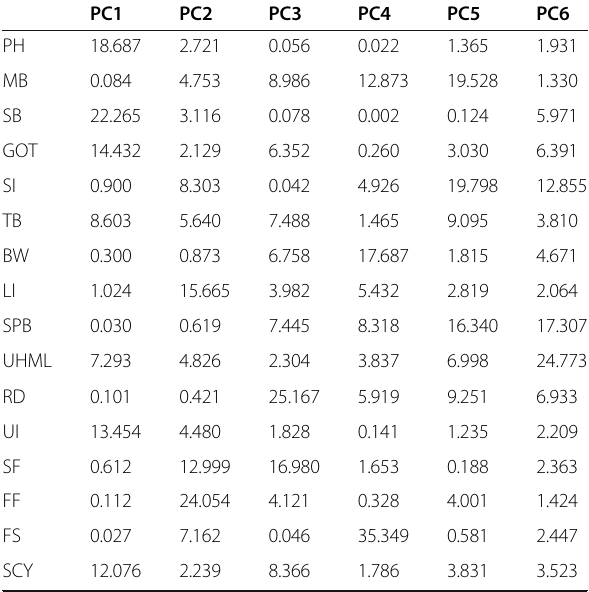
Table 9 Contribution of variables to total